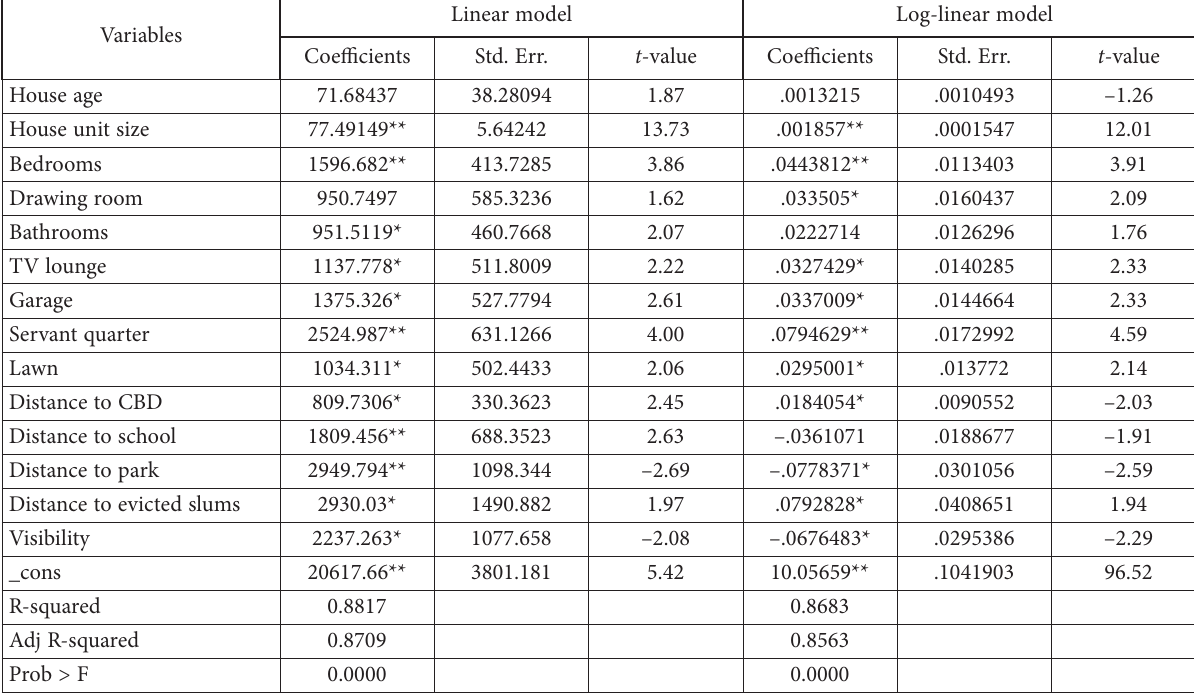
Table 6. Showing estimates of a linear and semi-log model with data from evicted slum sites